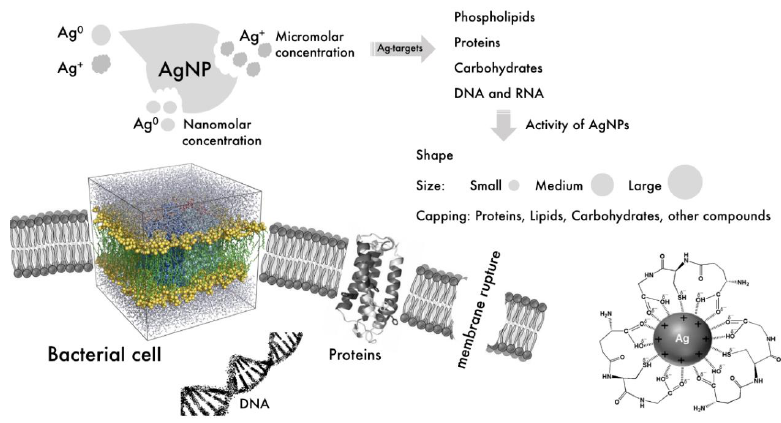
Figure 3. Summary of the factors affecting the antimicrobial capacity of AgNPs and main antibacterial mechanisms. Size, shape and capping agents have a significant influence on the activity against bacterial cells, which are susceptible to nanoparticles because of a strong affinity of the metal with the cell wall and membrane, as well as due to interference in the respiratory chain and generation of reactive oxygen species (ROS).